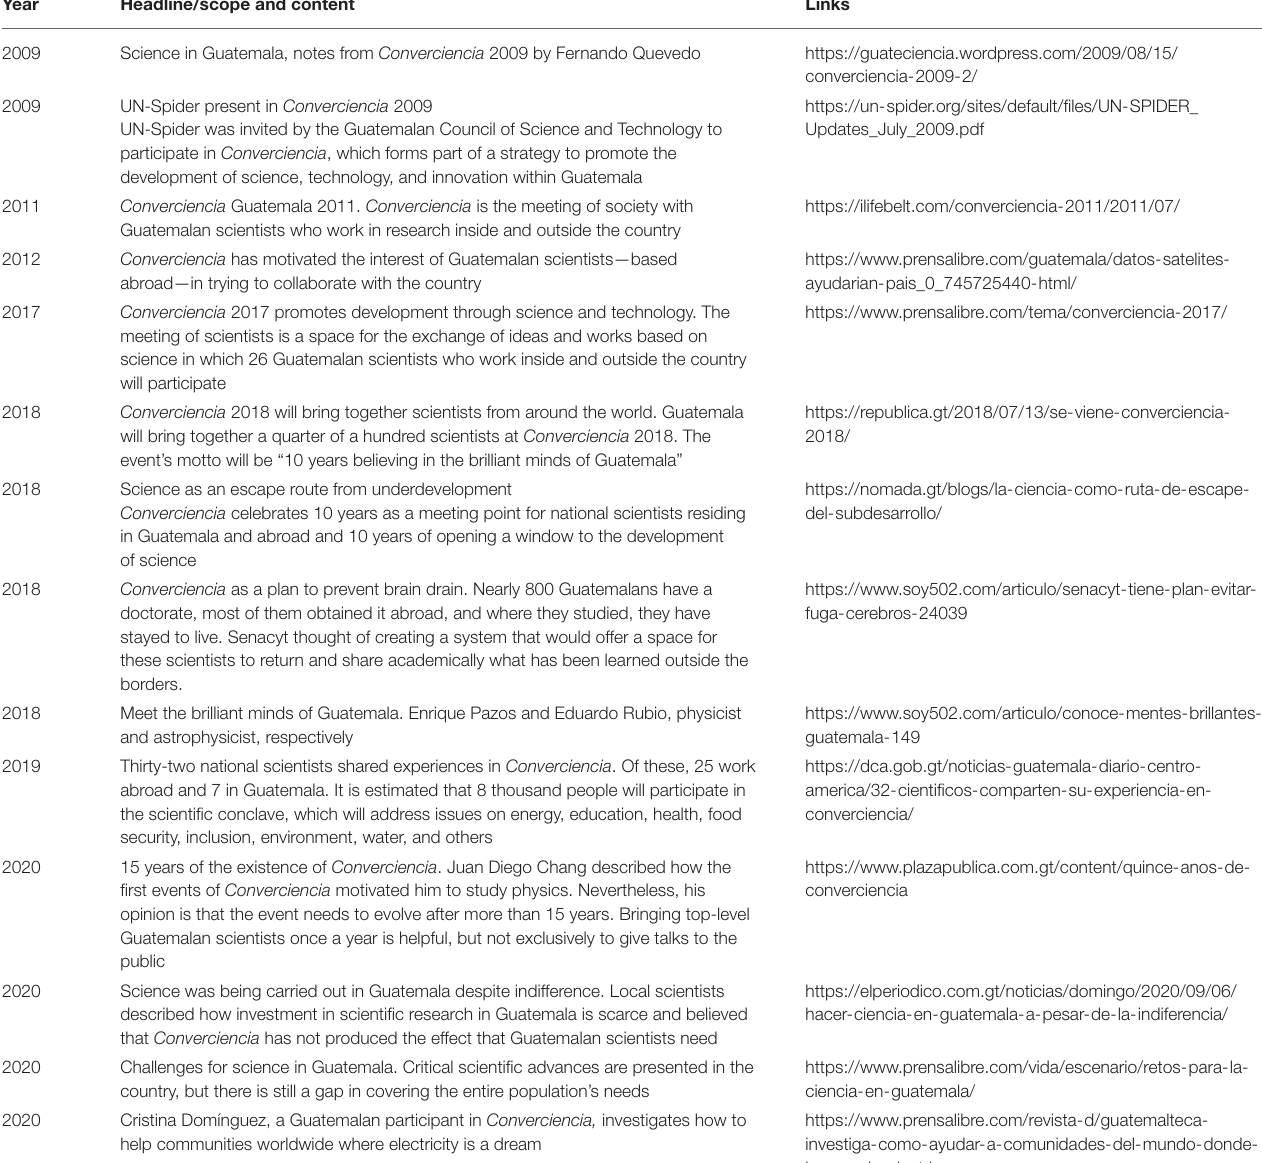
TABLE 7 | Descriptive analysis: selected media coverage, Converciencia